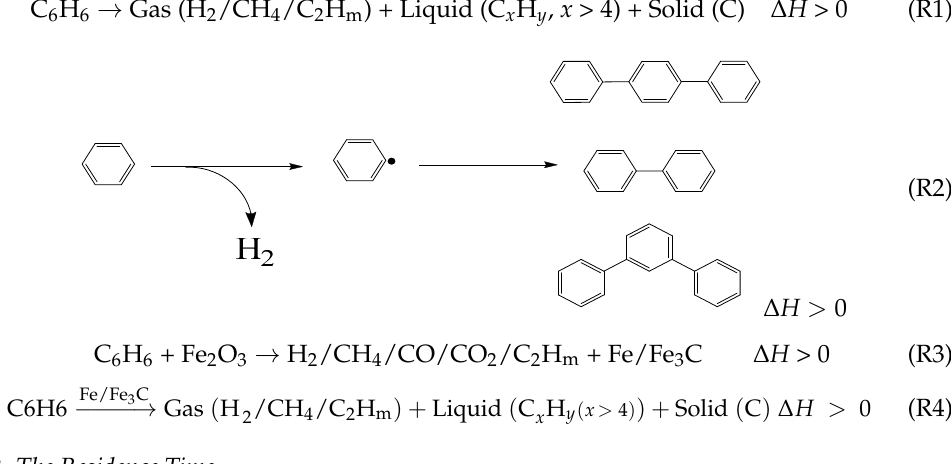
Table 3. Distribution of liquid products during benzene cracked by two carriers.